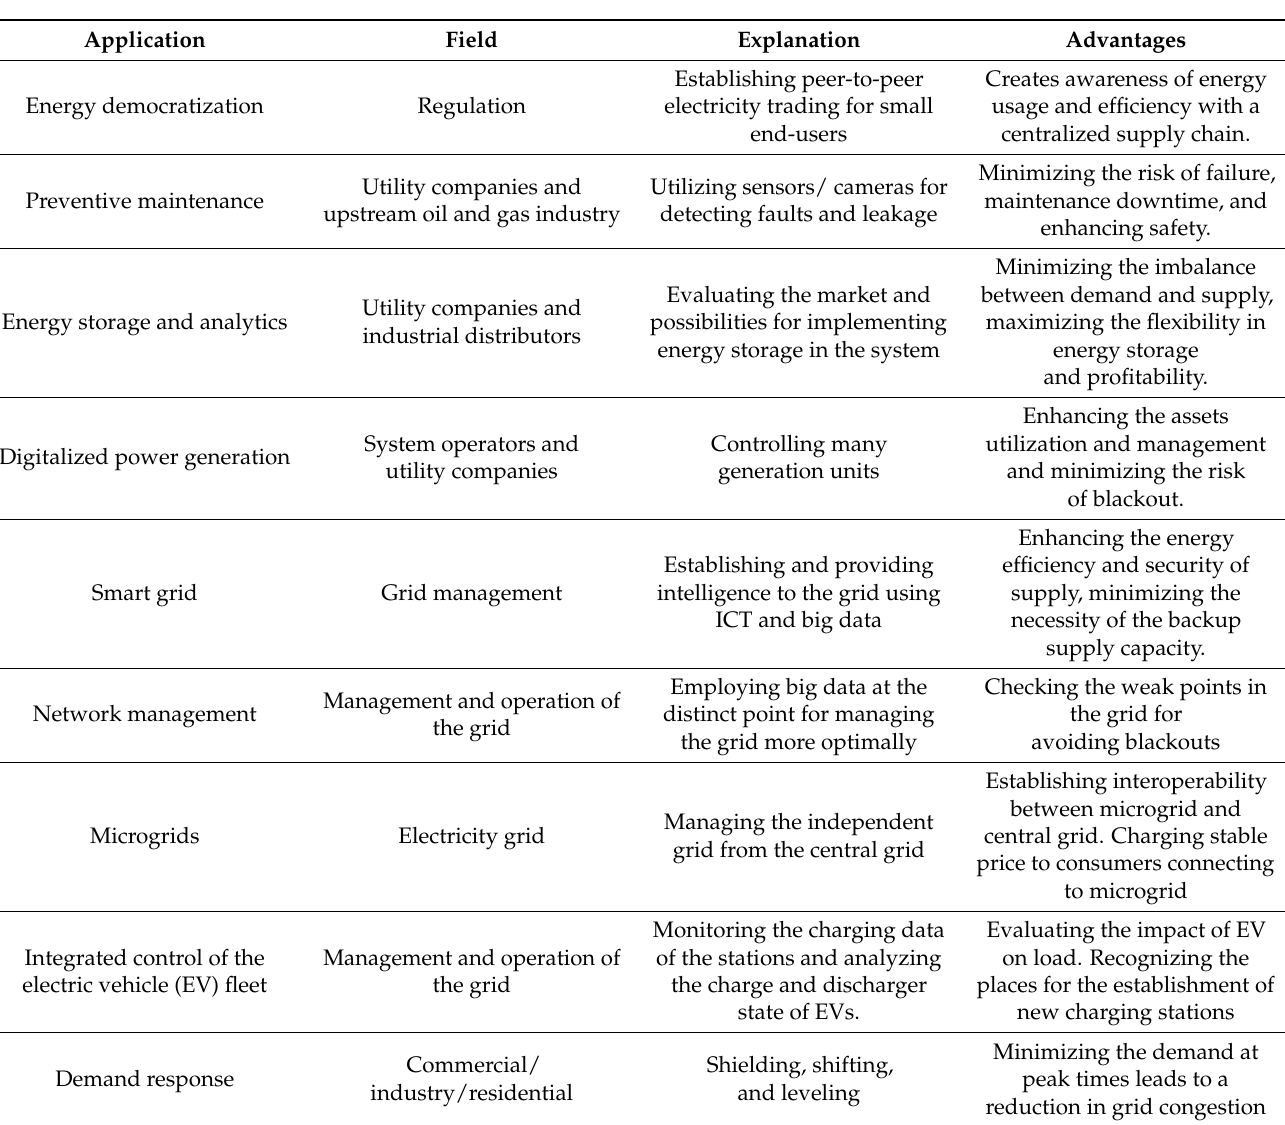
Table 1. Applications of IoT for the energy